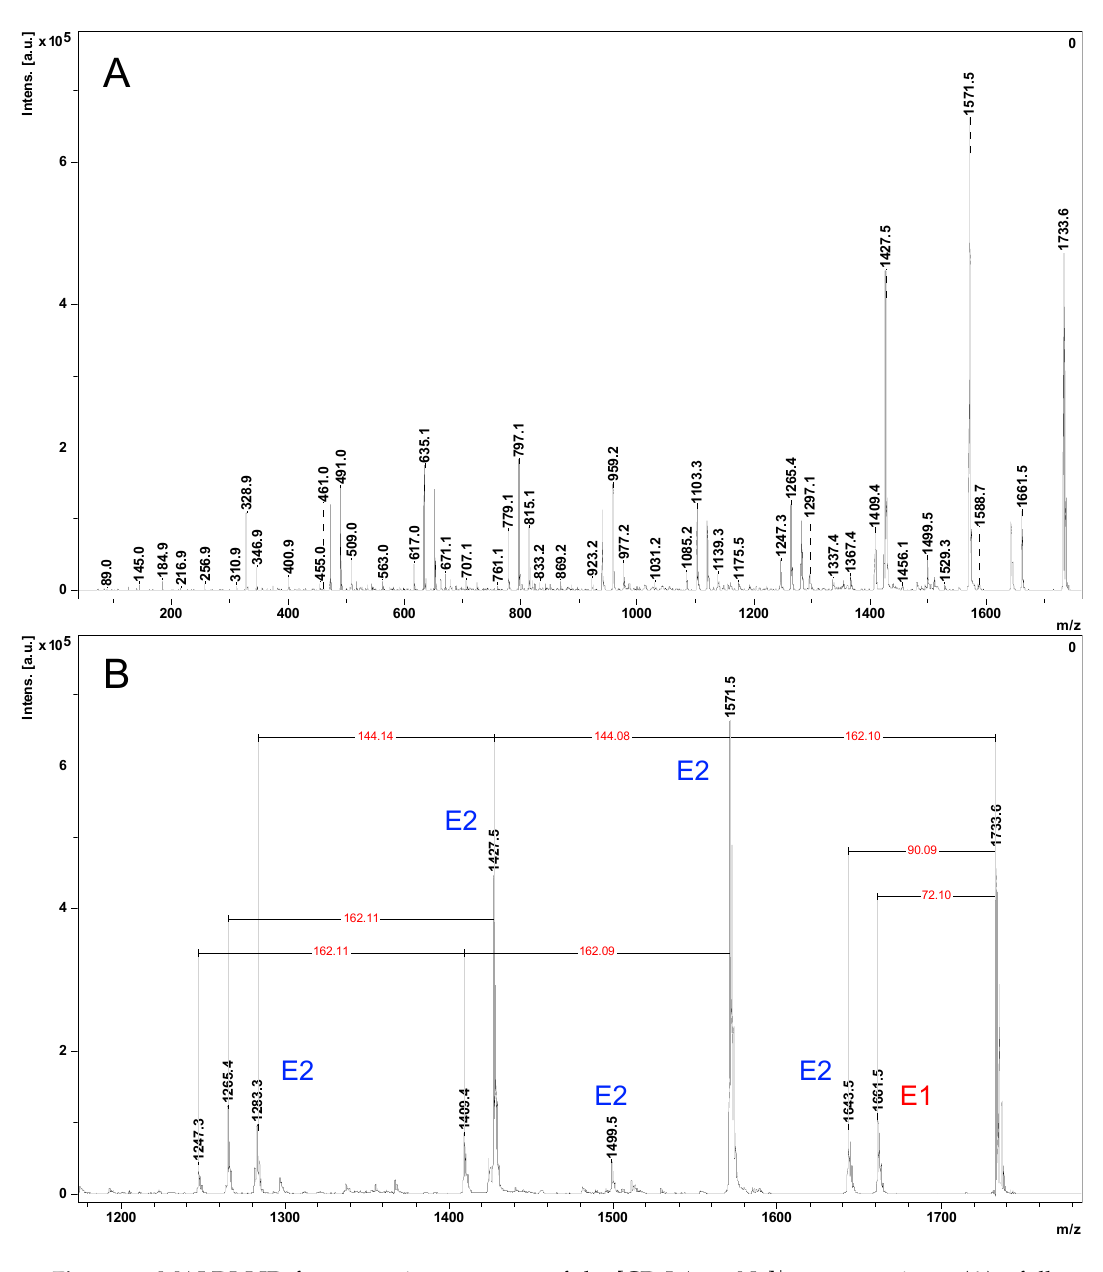
Figure 3. MALDI LID fragmentation spectrum of the [CD-LA 4 + Na] + precursor ions: ( A )—full spectrum, ( B )—enlarged region between m / z —1200–1800.